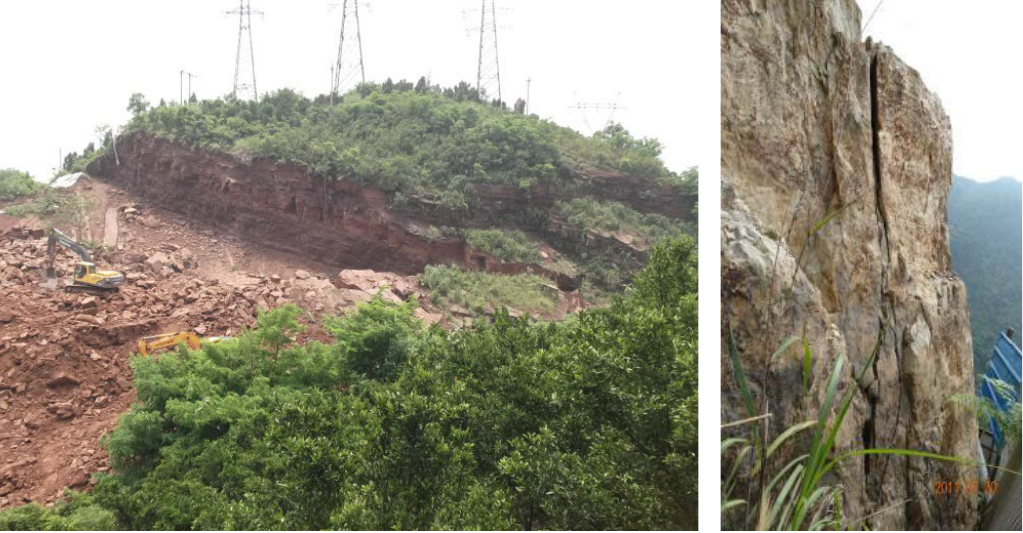
Figure 1. Landslide and collapse caused by joints.